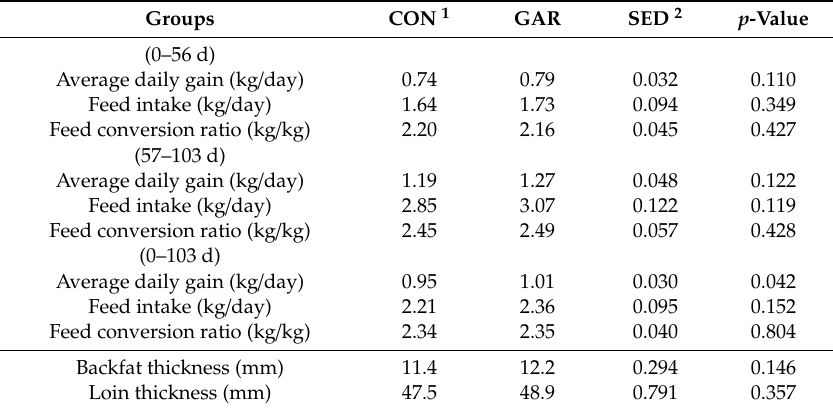
Table 4. The e ff ect of dietary inclusion of Allium spp. extract on the in vivo performance of growing-finishing pigs.